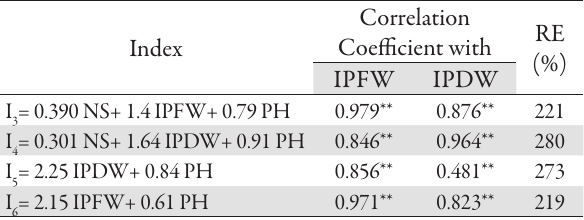
Tab. 3. Selection indices, correlation coefficients with yield and relative efficiency (RE) in adult plant